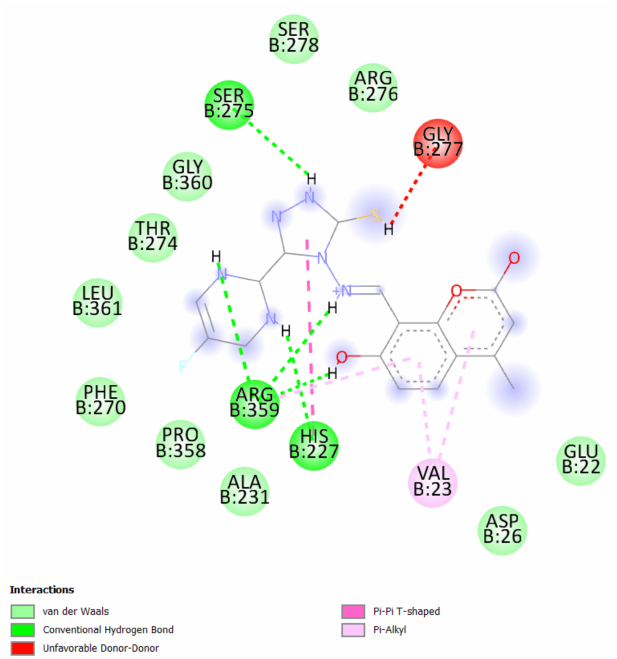
Figure 10. Docking interactions of designed compound b with vinblastine binding site of tubulin enzyme of human.